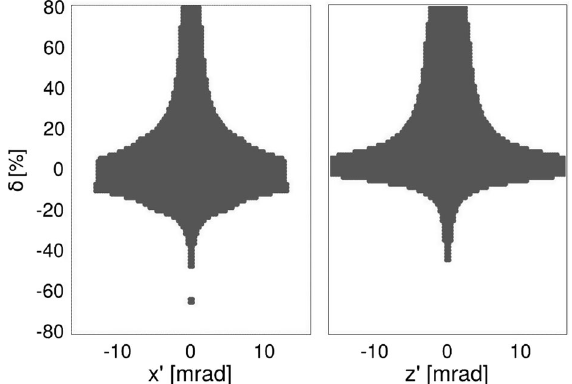
11. (Left) horizontal and (Right) vertical acceptance of the transport line. Beam energy at 180 MeV using S2I-CM optics with r 11 ¼ r 33 ¼ 10 and r 56 ¼ 0 . 4 mm. Beam transport simu- lation in the nonlinear case with BETA and sympletic 6D